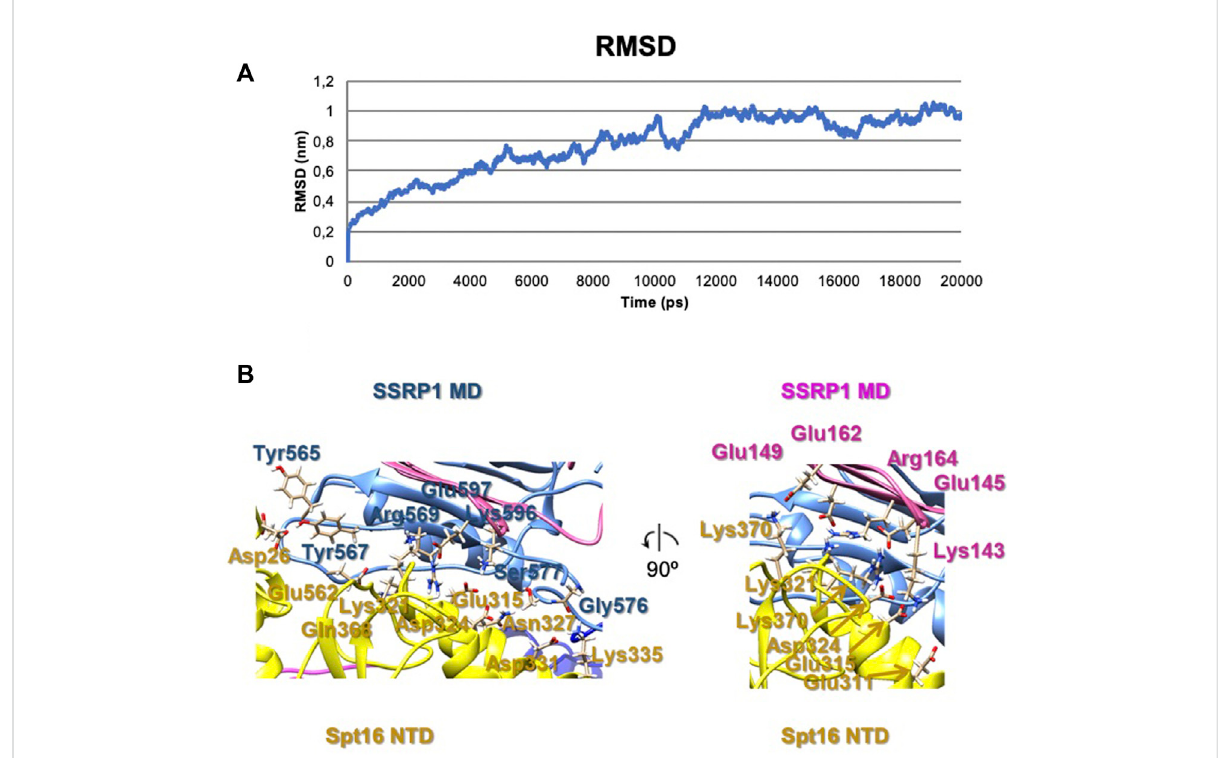
The results of molecular dynamics simulations of the compact FACT conformation. (A) RMSD of C α of the whole complex [(SSRP1-NTD/DD- SPT16-DD(domainII),SSRP1-MD(domainI)andSPT16-MD(domainIII)] (B) Contactsbetweenthesubunitsinthecomplexaftermoleculardynamics